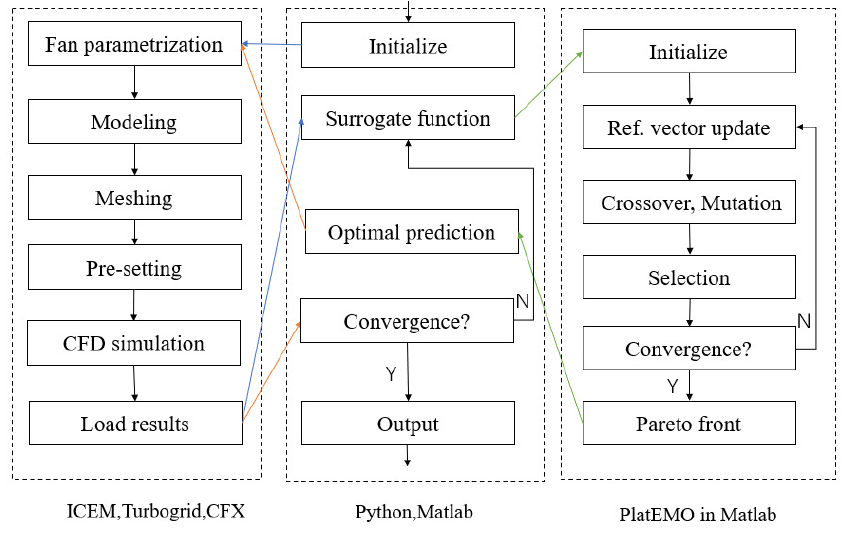
Figure 17. Comprehensive flow chart of the fan optimization framework.